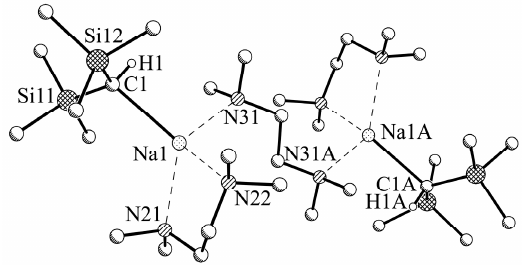
Figure 6. Molecular structure of [NaCH(SiMe 3 ) 2 ] 2 -3TMEDA, 2b . Selected hydrogen atoms and disordered units of minor occupancy are omitted for clarity. Symmetry operator A: − x +1, − y +1, − z +2.